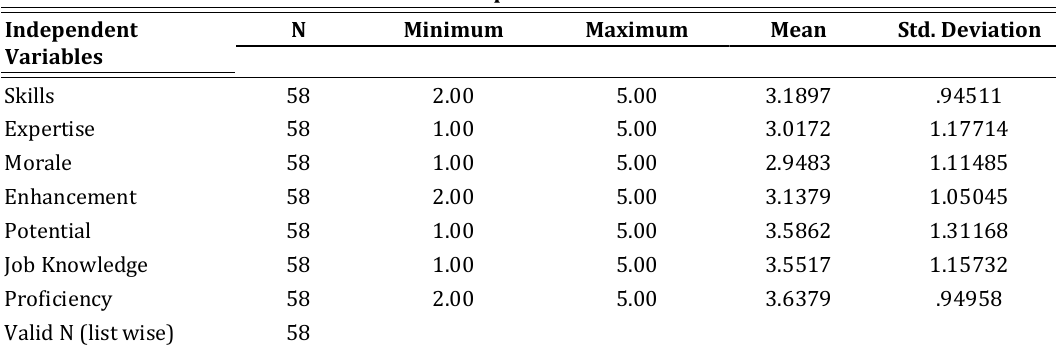
Table 4.2.3 is the Description of Statistics on the selected Variables. From the Mean scores